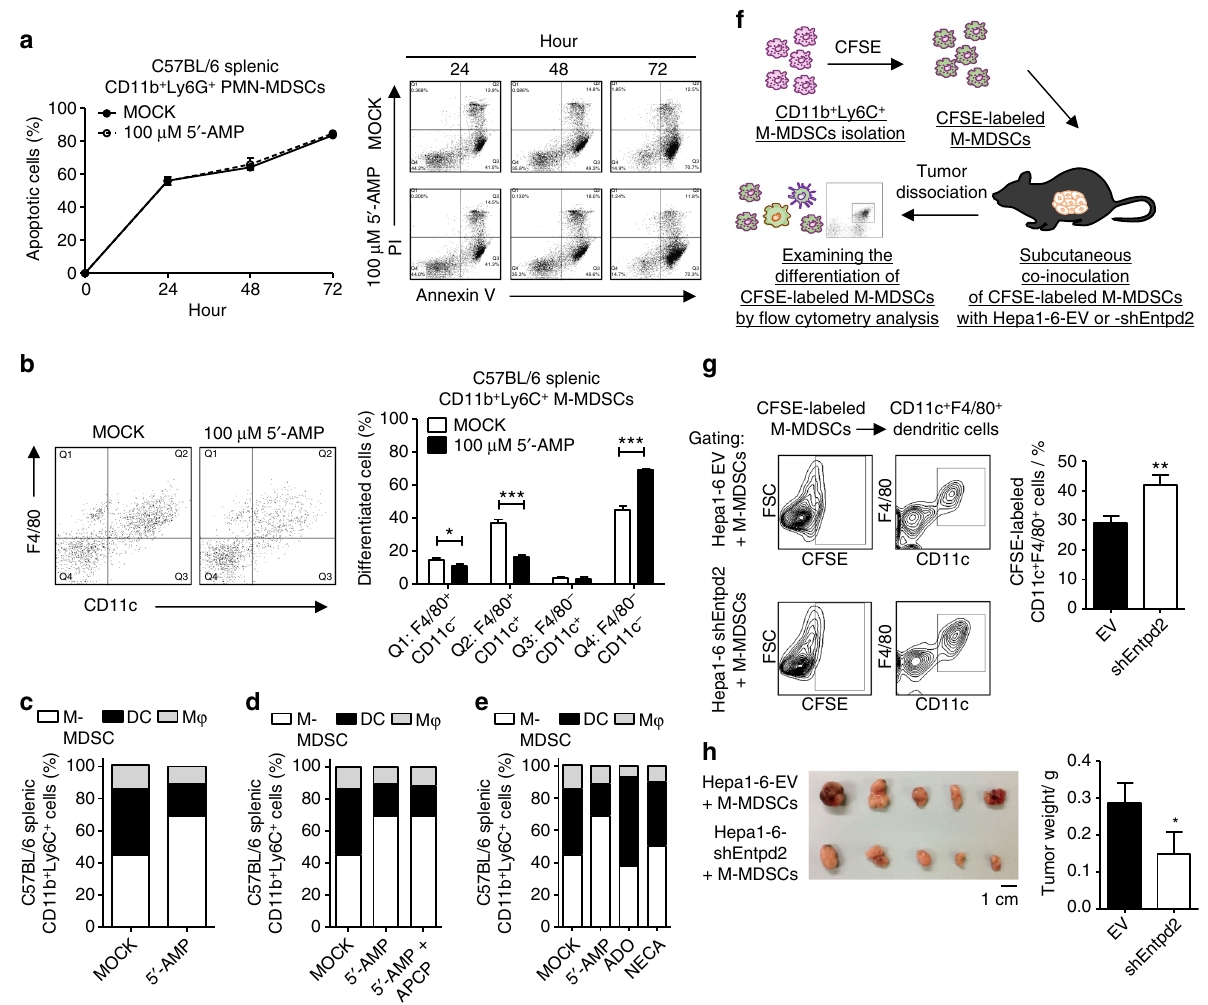
Fig. 5 5 ′ -AMP impairs M-MDSC differentiation to dendritic cells. a The effect of 5 ′ -AMP on apoptotic rate of PMN-MDSCs. Splenic CD11b + Ly6G + cells isolated from C57BL/6 mice were cultured with or without 100 µ M 5 ′ -AMP for annexin V assay at different time points ( n = 3). The effect of 5 ′ -AMP or adenosine on M-MDSC differentiation. Splenic CD11b + Ly6C + cells isolated from C57BL/6 mice were cultured for 4 days b , c with or without 100 µ M 5 ′ - AMP, d with 100 µ M 5 ′ -AMP in the presence or absence of NT5E inhibitor, APCP, or e with 100 µ M 5 ′ -AMP, 100 µ M adenosine (ADO), 100 µ M 5 ′ -APCP, or 100 µ M NECA. Expression for two surface markers, CD11c and F4/80, were analyzed by fl ow cytometry and the distribution of CD11c − F4/80 + macrophage (M φ ), CD11c + F4/80 − and CD11c + F4/80 + dendritic cell (DC) and CD11c − F4/80 − M-MDSC populations were determined by the surface markers ( n = 3). f The effect of ENTPD2 on the fate of M-MDSCs in vivo. Splenic CD11b + Ly6C + cells isolated from C57BL/6 mice were stained with fl uorescent cell tracking dye CFSE and co-inoculated with Hepa1-6-EV or shEntpd2 clones into C57BL/6 mice subcutaneously ( n = 5 for each groups). g The tumors were dissociated and stained with anti-CD11c and anti-F4/80 to examine the differentiation of CFSE-labelled M-MDSCs ( n = 5 for each groups). h Tumor weights were measured ( n = 5 for each groups). Data are presented as mean ± s.d. (Student ’ s t -test, * P < 0.05, ** P < 0.01, *** P <